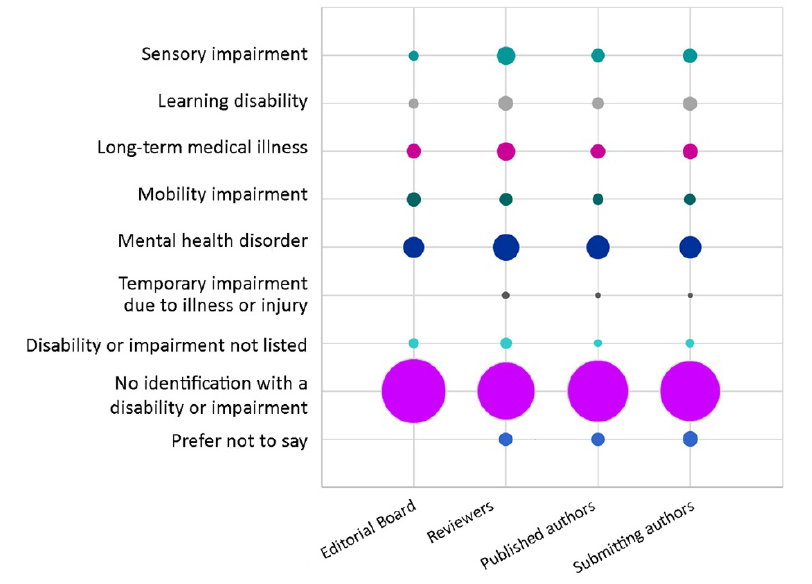
Within each group along the y-axis, the size of the bubbles indicates the percentage of respondents who selected each